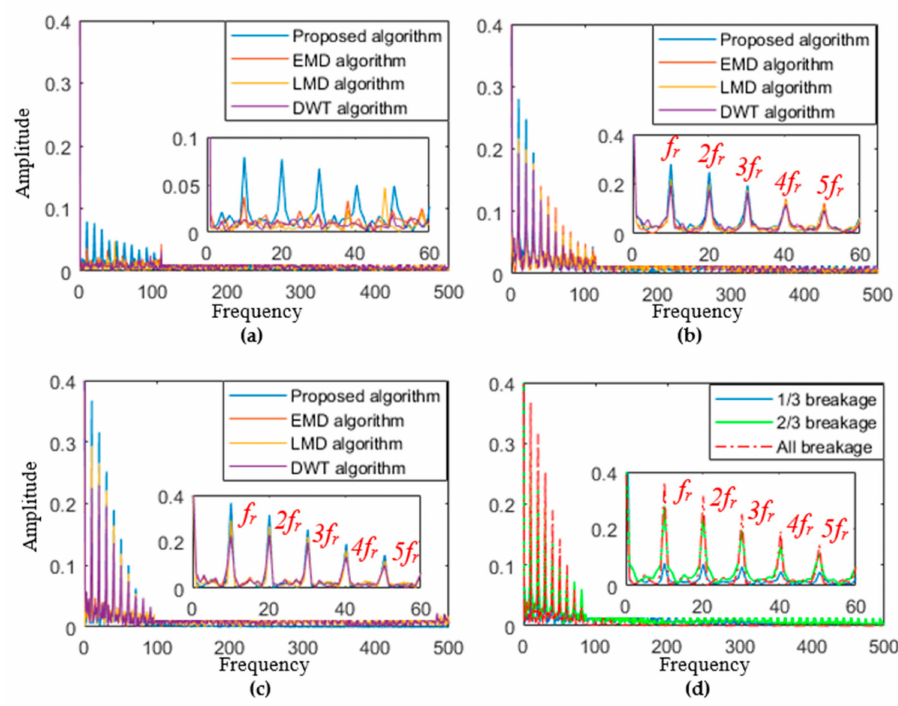
Figure 8. The results comparison ( a ) 1 / 3 breakage, ( b ) 2 / 3 breakage, ( c ) total breakage, ( d ) the proposed method with di ff erent breakage.